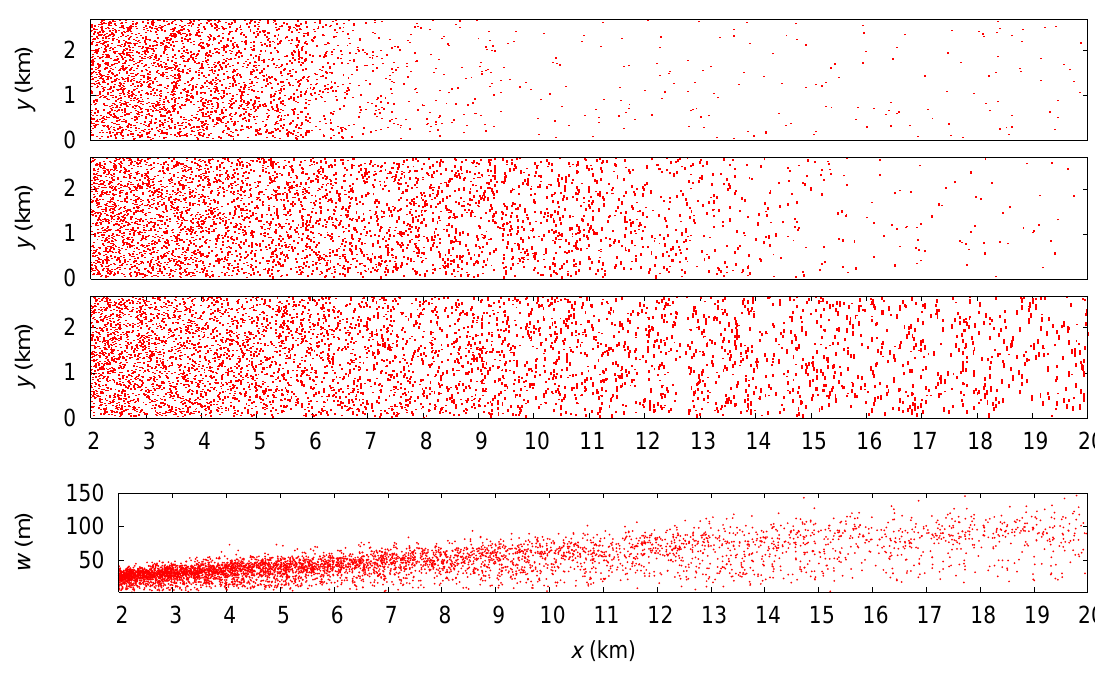
Fig. 9. Top, three characteristic stages of the evolution of a dune field at 20yr (2 × 10 4 steps), 50yr (5 × 10 4 steps) and the steady state after about 100yr (10 5 steps). Dunes move from left to right and are represented by the “width line”, i.e. a line centered in the center of mass of the dune and with a length equal to the dune width. Bottom, dune width w as function of its distance downwind at the steady